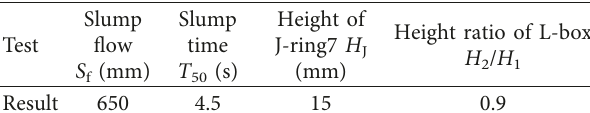
Figure 1: Fiber bundle-plastic chain model (BCM) [20] (a) and its typical predicted probability density of micro-yield-damage P [20] (b), comparing with the energy computed by acoustic emission (AE) g EA [19] (c) and the probability density of hardness modulus of nanoindentation PDF [19] (d). Table 1: Workability test results of